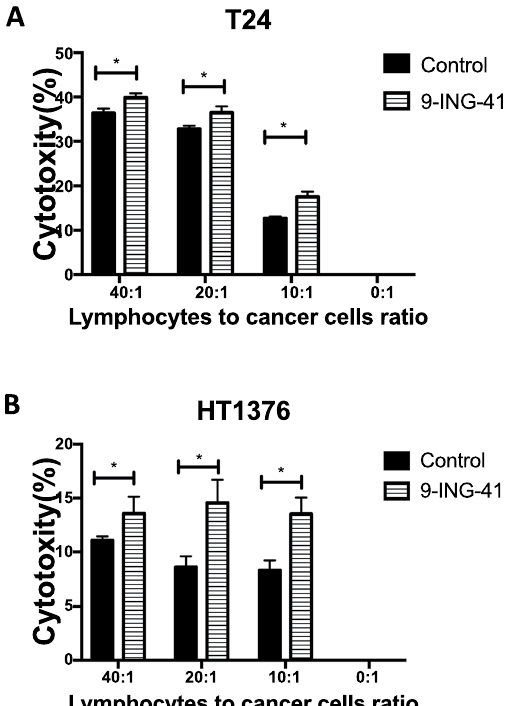
Figure 5. Treatment with 9-ING-41 sensitizes bladder cancer cells to cytotoxic effects of human immune cells. T24 ( A ) and HT1376 ( B ) bladder cancer cells were treated with 9-ING-41 for 48 hrs as indicated, harvested and mixed with human immune cells. LDH activity of supernatant was measured for evaluation of cytotoxicity. Columns, mean; bars, SD. Statistical analysis was performed using unpaired t-test. * P <